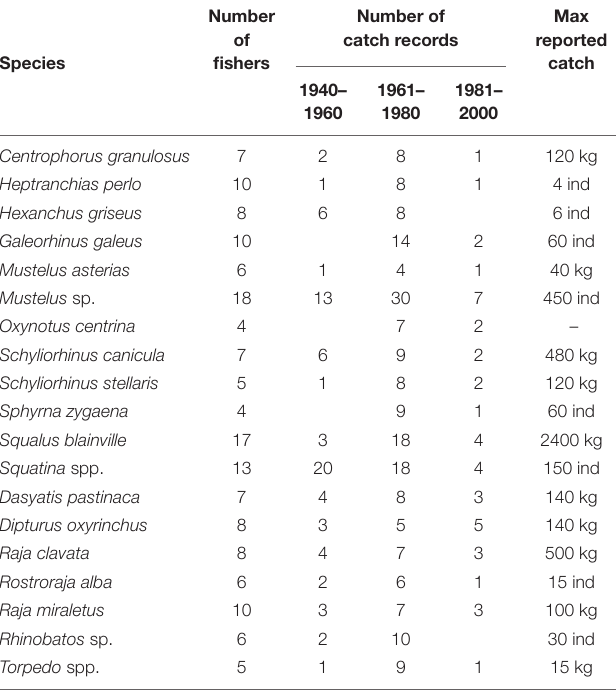
TABLE 1 | List of the elasmobranchs species considered during the interview with the number of fishers providing data, the number of catch records and the maximum daily catch in kilograms or n. individuals reported by